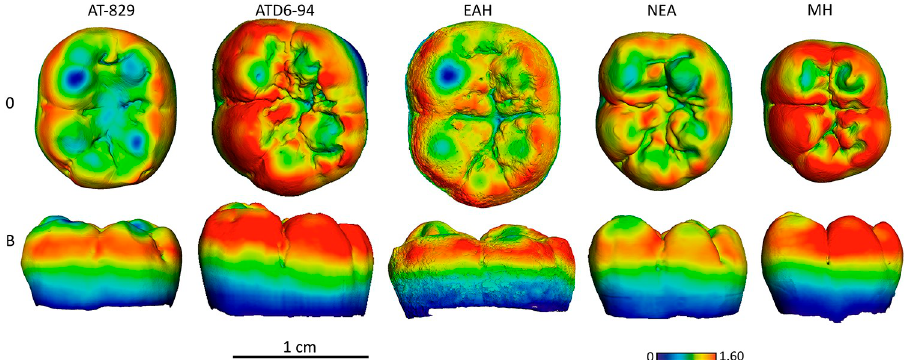
Fig 12. Enamel thickness cartographies of the Atapuerca-SH lower M1 (AT-829) compared with those of Mulhuli- Amo, H . antecessor (ATD6-94) from Atapuerca-Gran Dolina, Neanderthal and modern human. Topographic thickness variation is rendered by a pseudo-color scale ranging from thinner dark-blue to thicker red. EAH = MA93, NEA = Neanderthal (S14-7) and MH = modern human of European origin (O = occlusal, L = lingual). Scale bar = 1.60 for all specimens. (When needed specimens have been mirrored to the left to match the SH